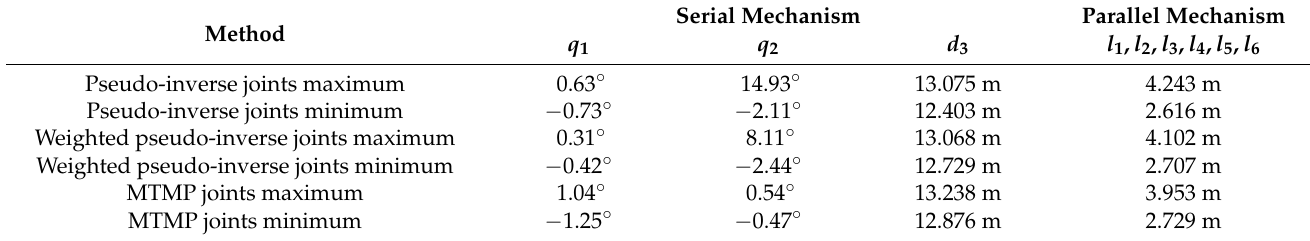
Table 7. The maximum and minimum values of the internal joint motion planning process of the three methods of the hybrid mechanism, for the same trajectory input in the 200 s simulation